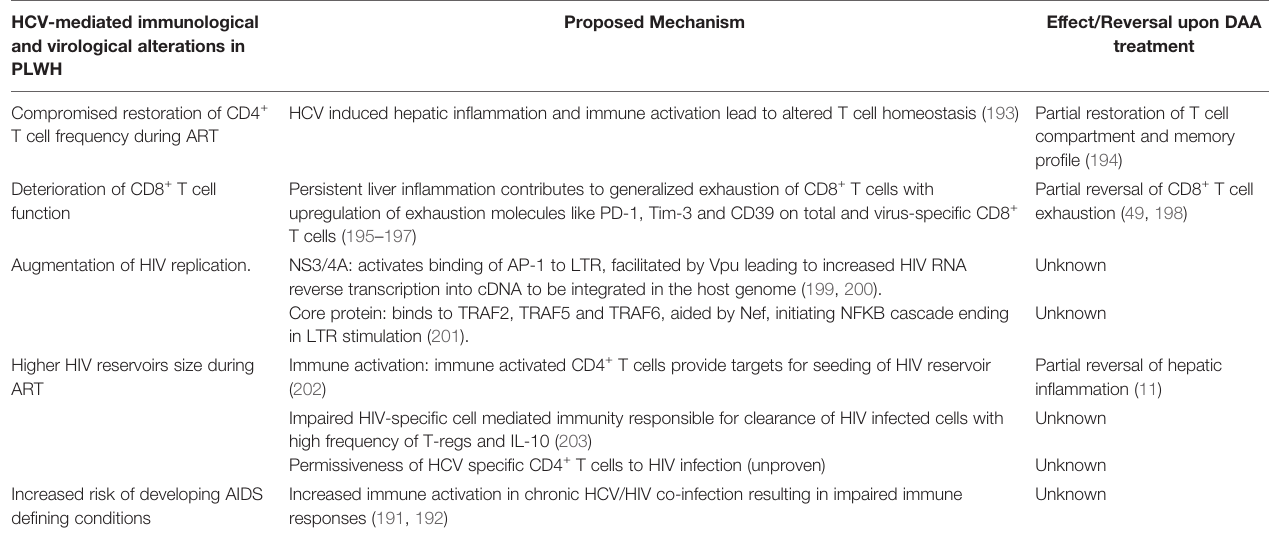
Proposed Mechanism